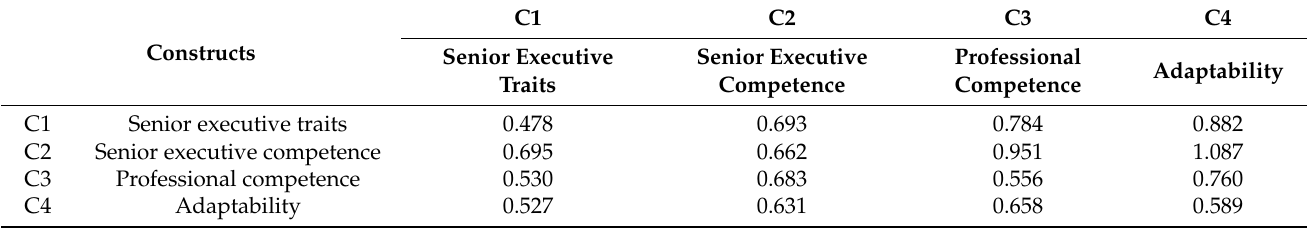
Table 8. Fuzzy DEMATEL total-influence matrix of the defuzzified